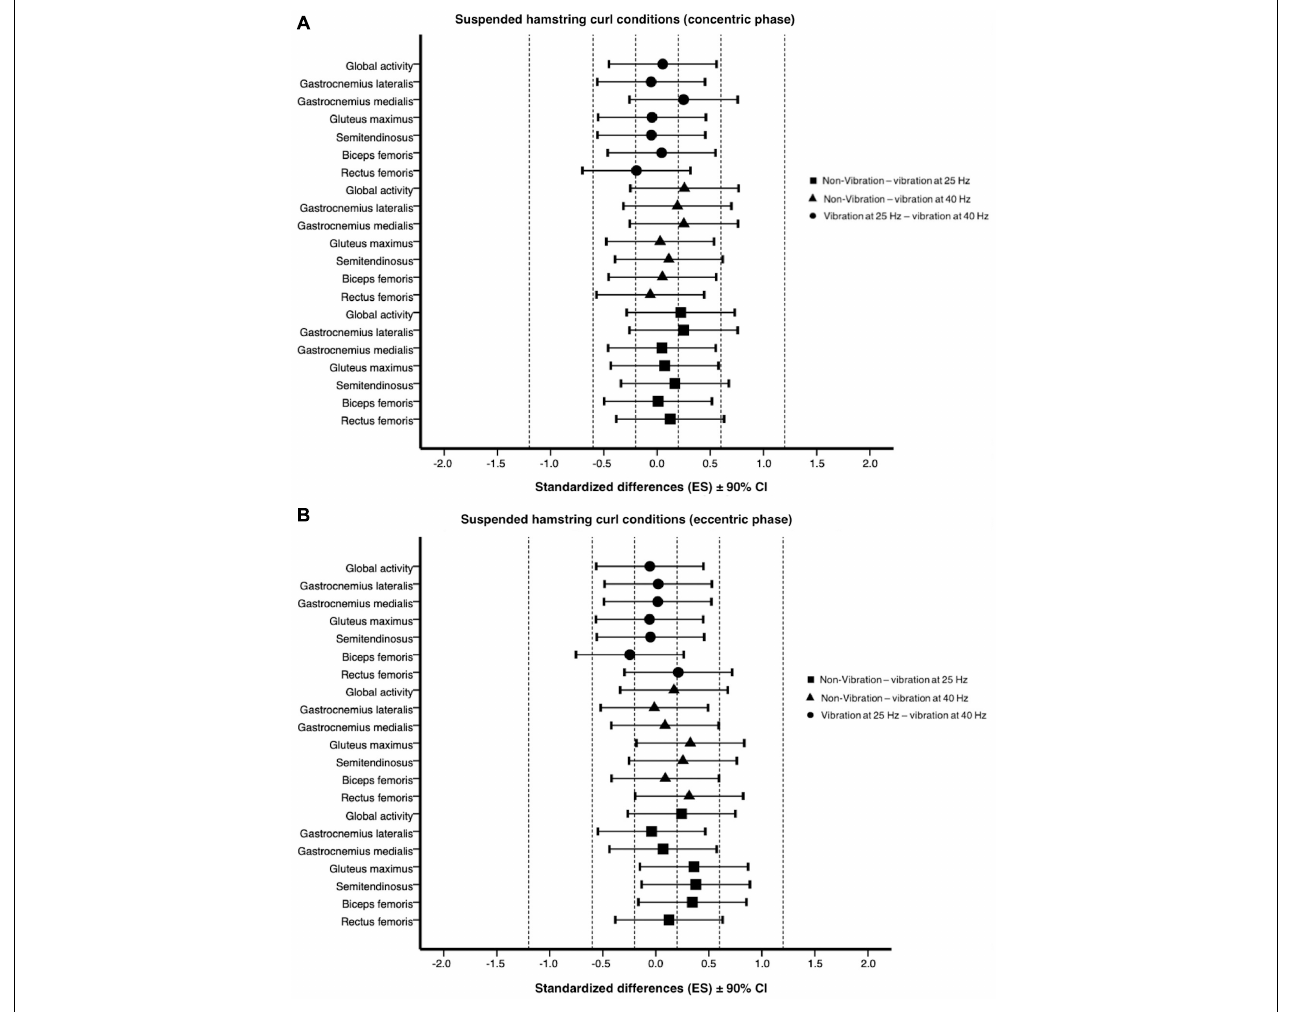
FIGURE 4 | Effects of suspended hamstring curl conditions on muscle activity (%MVIC) at concentric (A) and eccentric phase (B) expressed as standardized differences (Cohen’s d ) ± 90% CI. Dotted line represents the effect size thresholds. ES, effect size; CI, confidence